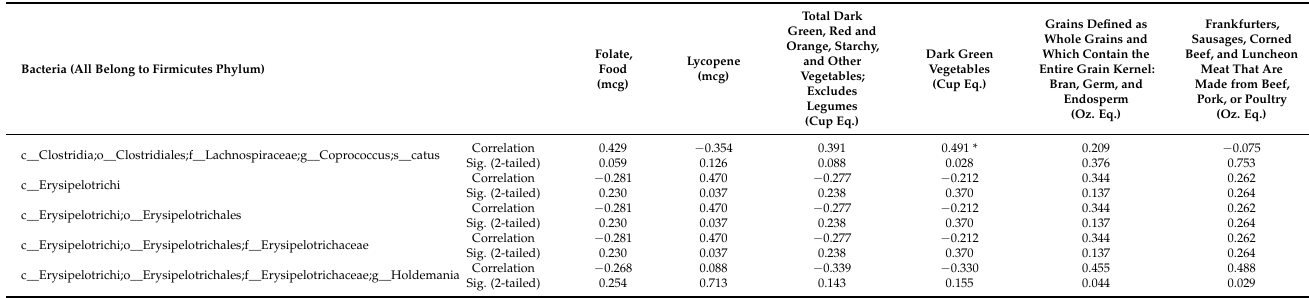
* numbers highlighted in red are significantly different. Table 4. Correlations between significant bacteria and significant nutrient/food